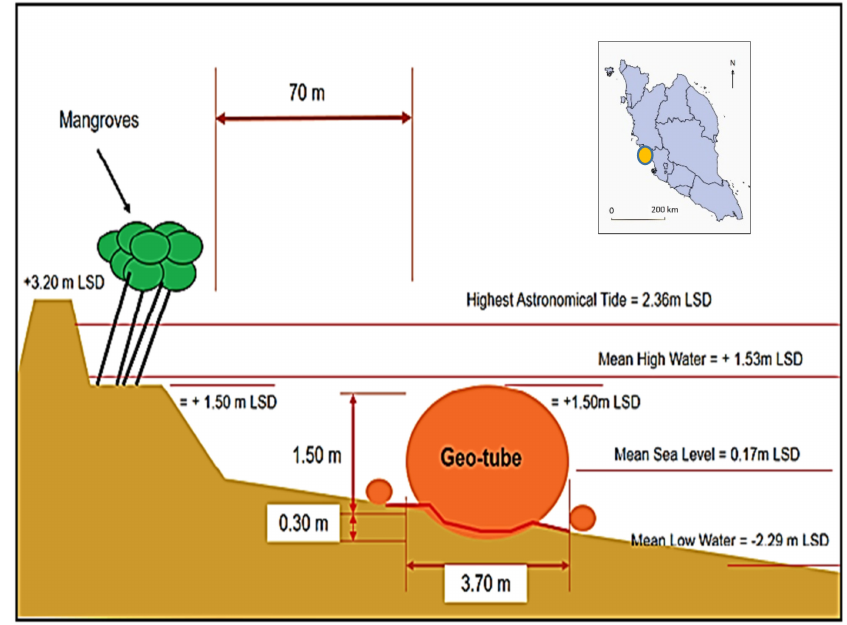
Figure 13. Geotube as shoreline erosion control and mangrove rehabilitation [97]. ‘Reprinted from Establishment of Shoreline Buffer Zone through Rehabilitation of Degraded Coastal Mangroves, 2019; open access publication by MATEC Web